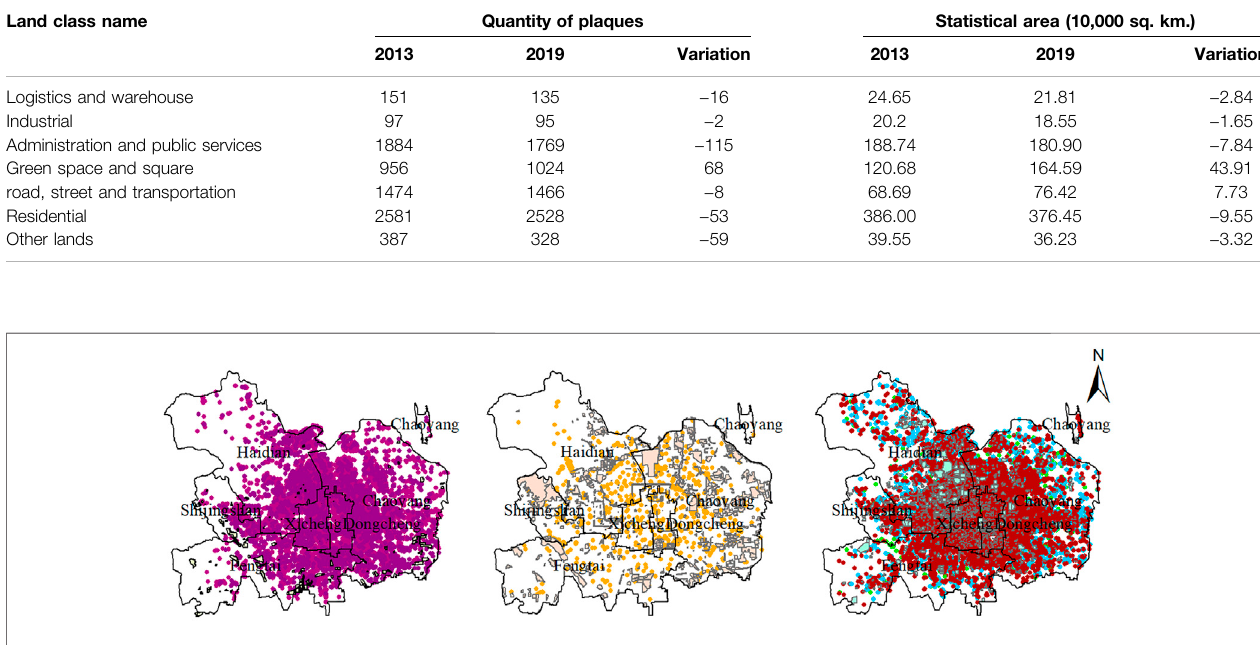
TABLE 4 | Statistics of patch quantity and area of seven types of land.